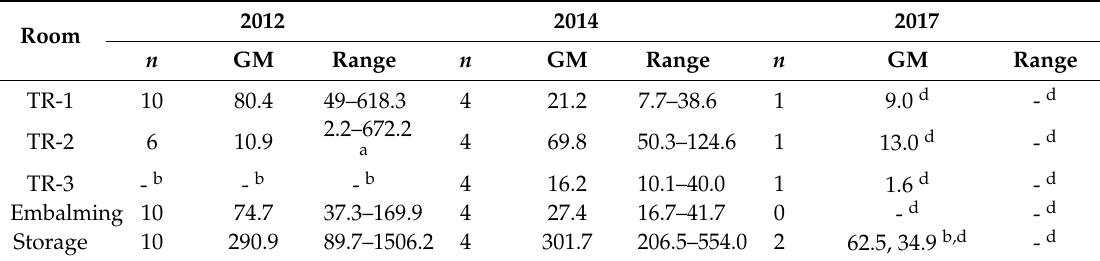
Table 3. Geometric mean concentrations (range) of FA ( µ g/m 3 ) at fixed locations.